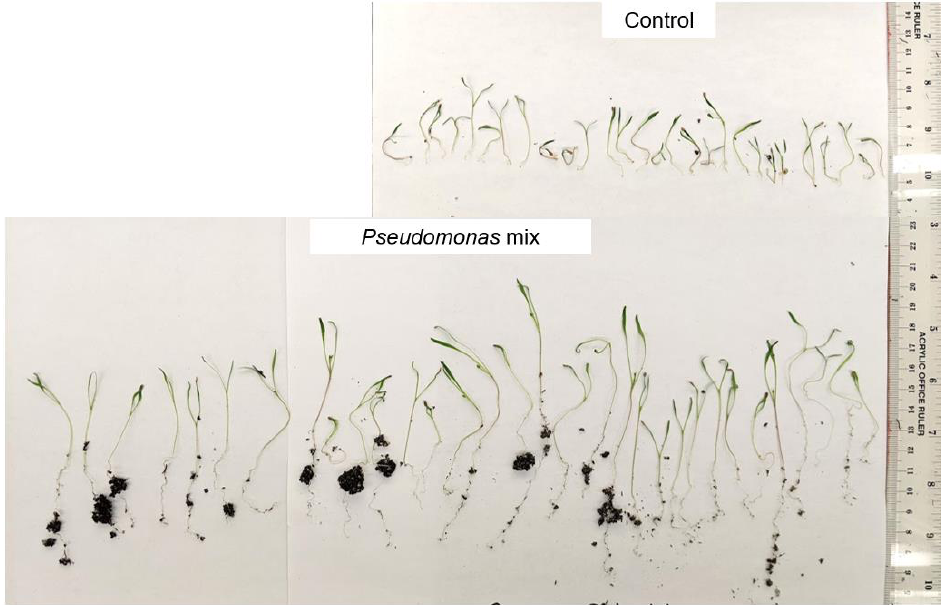
Figure 6. Visual comparison of carrot seedlings inoculated with a Pseudomonas sp. mix. Total number of seedlings germinated = 29, and 31, from top to bottom.